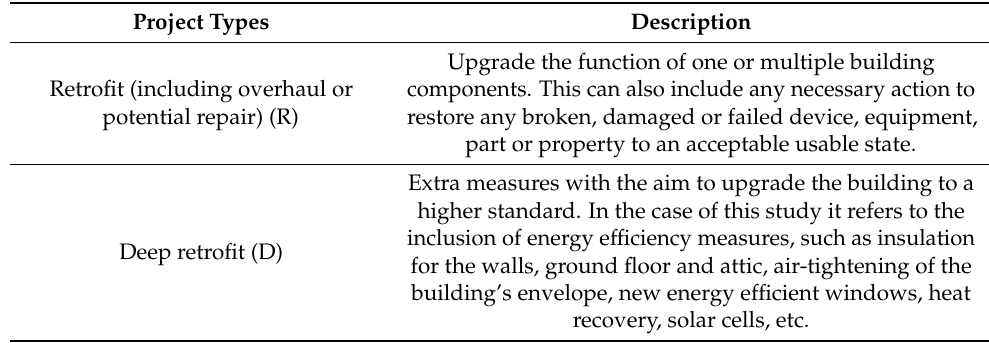
Table 2. Characterization of project types: definitions and